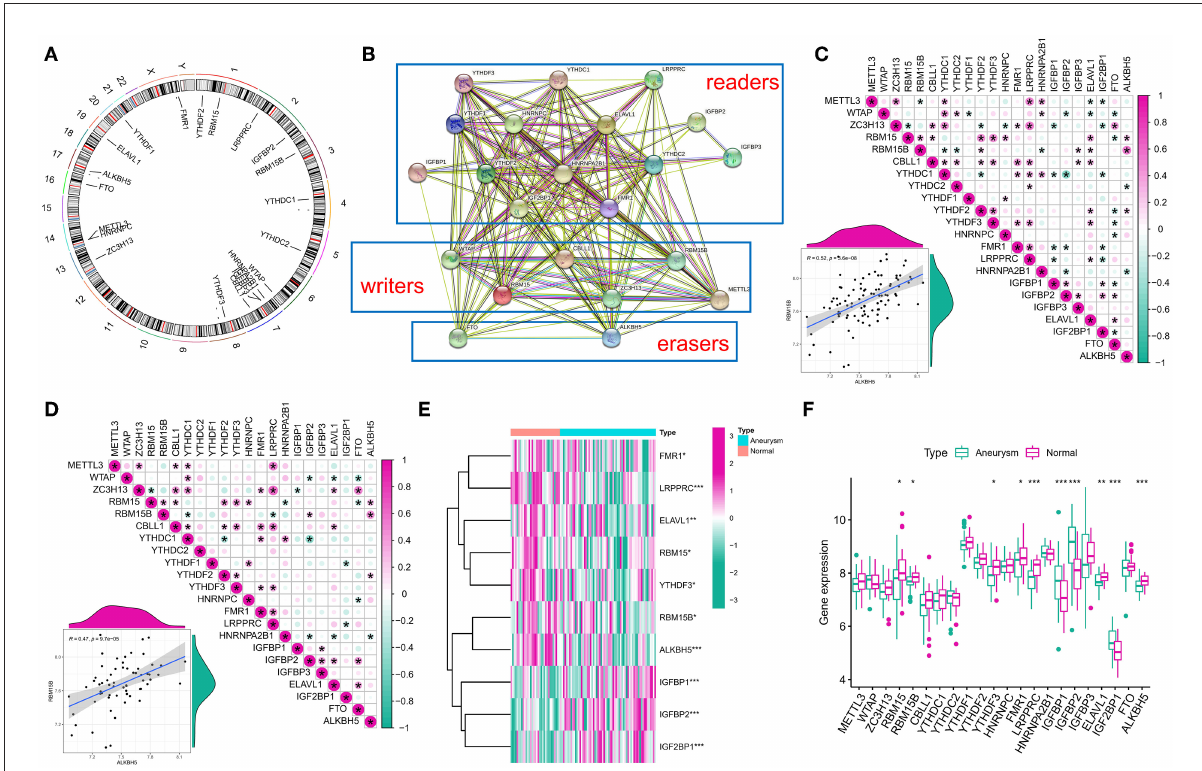
FIGURE1 Landscape of gene and expression changes of m6A modulators in the intracranial aneurysm (IA). (A) Position of the CNV alteration of the m6A modulators on 22 chromosomes from the GSE13353, GSE15629, GSE26969, GSE54083, and GSE75436 cohorts. (B) Overview of the composition of m6A modulators as well as the protein–protein interactions (PPI) across 22 m6A RNA methylation modulators. (C,D) Relations between the expression levels of 22 m6A modulators in all samples and intracranial aneurysm samples. The two scatter plots indicate the two most correlated m6A modulators: ALKBH5 and RBM15B. (E) Heatmap of remarkable differences in the expression levels of 10 modulators in IA and normal samples. (F) Box plot of the transcriptional state of the expression levels of 22 m6A modulators in IA and normal samples. The symbols * , ** , and *** indicates the value of p < 0.05, p < 0.01, and p < 0.001